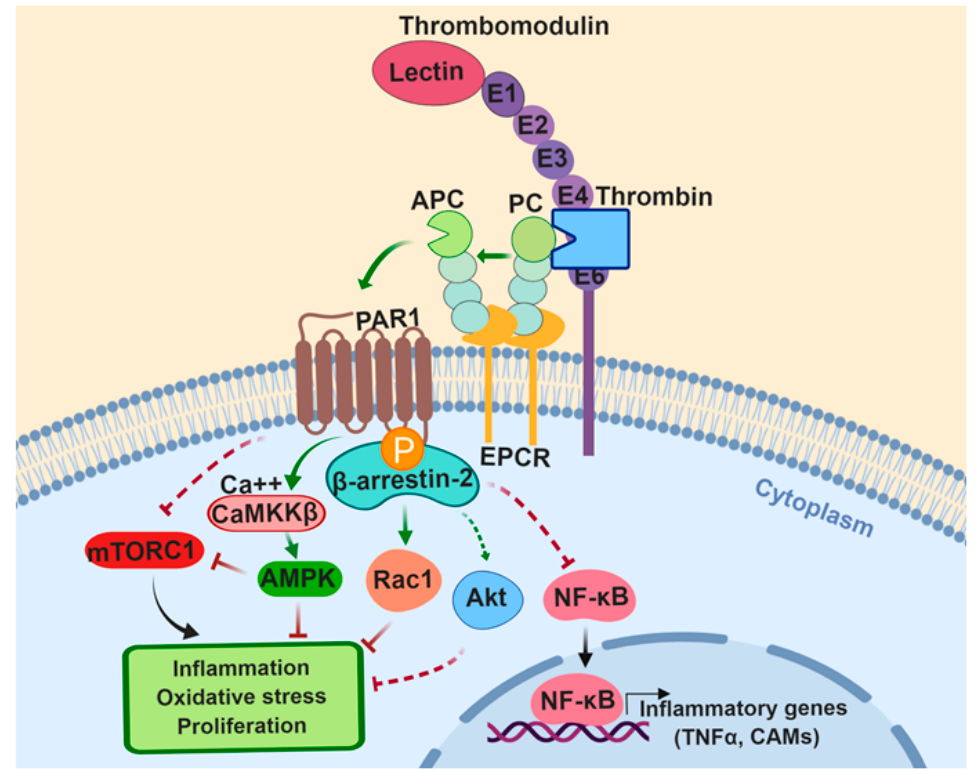
Figure 1. The protein C activation by the thrombin-thrombomodulin complex and the cytoprotective function of Activated Protein C (APC) in ischemic heart disease and heart failure. The Endothelial Protein C Receptor (EPCR)-dependent cleavage of Protease-Activated Receptor 1 (PAR1) by APC initiates β -arrestin-2 biased signaling that results in the activation of Rac1 GTPase, Akt, and AMPK by the Ca 2+ /calmodulin-dependent protein kinase-kinase β (CaMKK β ) pathway. The PAR1-biased signaling also inhibits the activation/nuclear translocation of NF- κ B and mTORC1 signaling network. E1, E2… represent EGF-like domains. See the text for more details. The figure was prepared by software provided by Biorender.com .